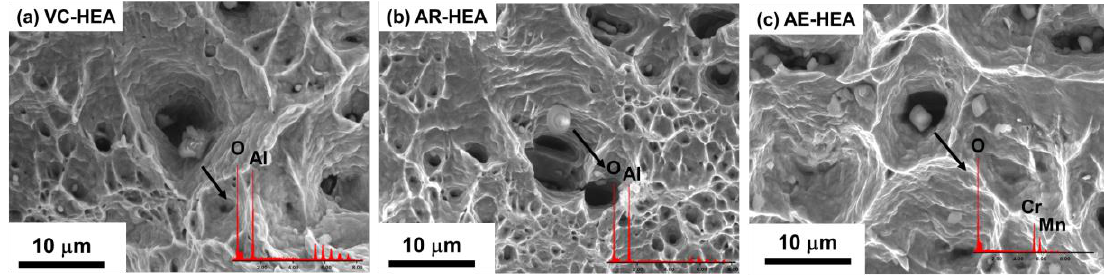
Figure 8. Fractography of ( a ) VC-HEA, ( b ) AR-HEA, and ( c ) AE-HEA. The chemical composition of particles in each dimple are represented with EDS peaks.